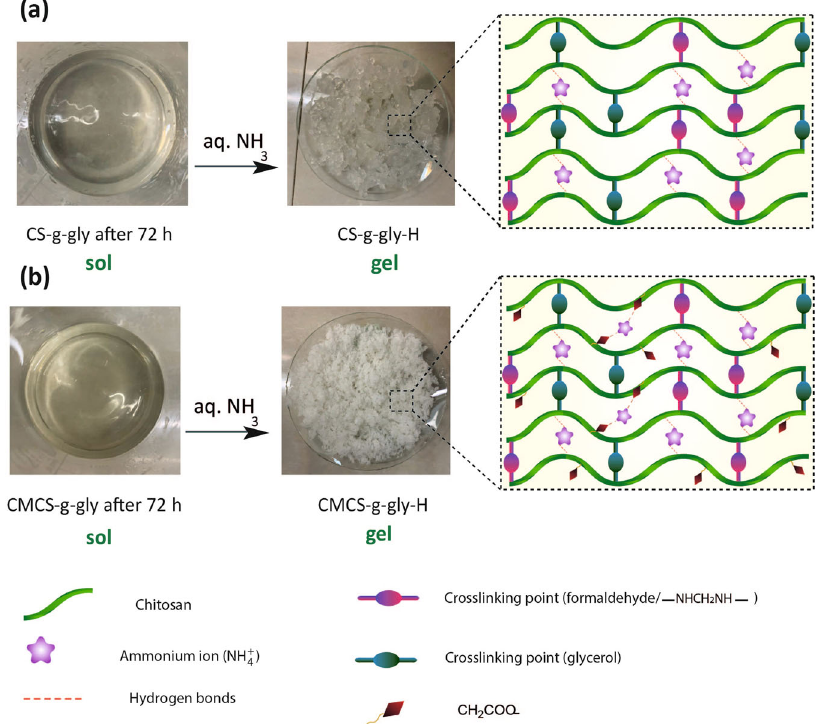
Fig. 2 Design strategy for CS-g-gly and CMCS-g-gly hydrogels. a Gelling of CS and ( b ) gelling of CMCS-g-gly with NH4 + binder after 48